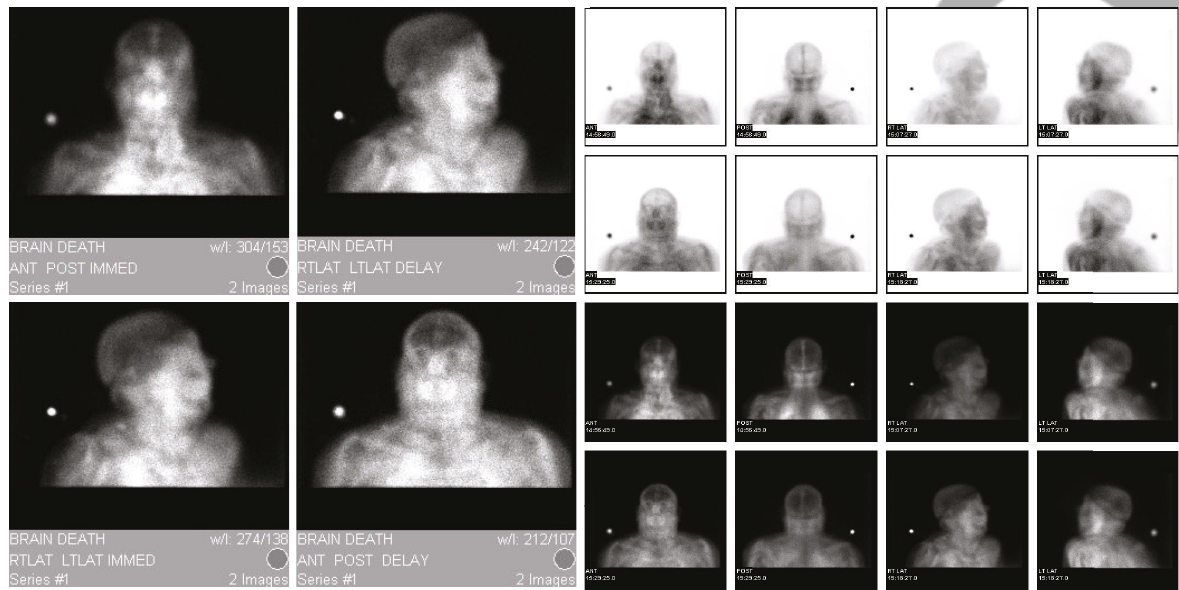
Figure 1: Patient #1. RCPS showing anterioposterior and lateral immediate and delayed images revealing no cerebral blood flow (empty skull